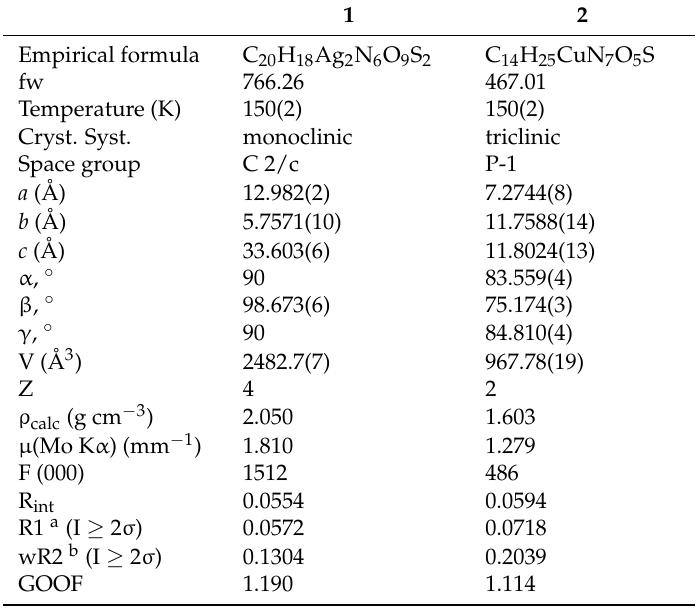
Table 6. Crystallographic data and structure refinement details for 1 and 2